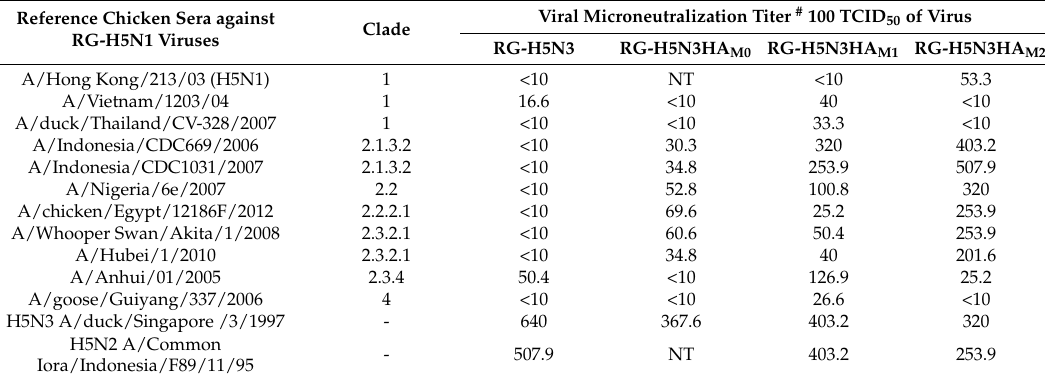
Table 1. Evaluation of antigenic relatedness of reverse genetics-derived H5N3 (RG-H5N3) mutants